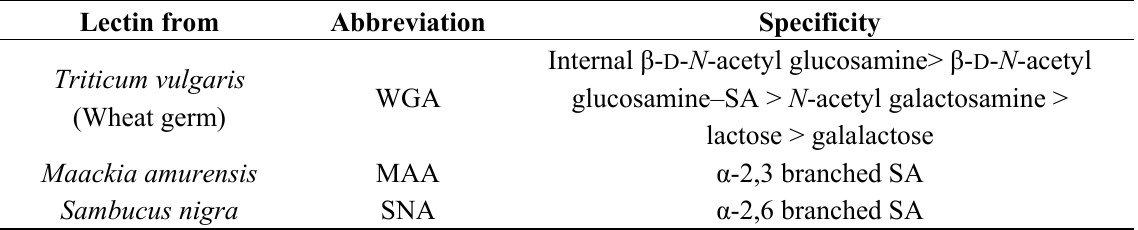
Table 1. Ligand specificity of WGA, MAA and